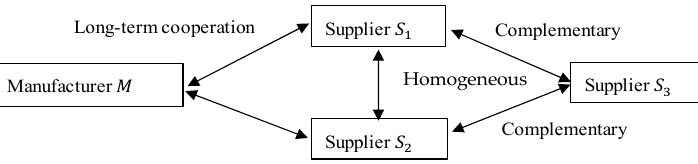
Figure 1. Relationships between the model’s main players.